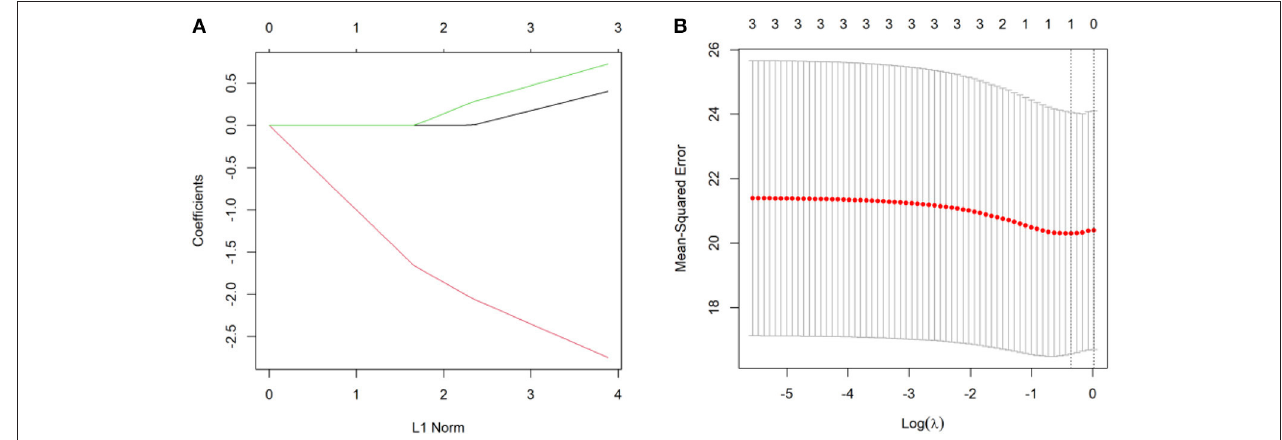
FIGURE 5 | (A) A Lasso coefficient curve for three independent variables. (B) A logarithmic (lambda) sequence coefficient distribution.